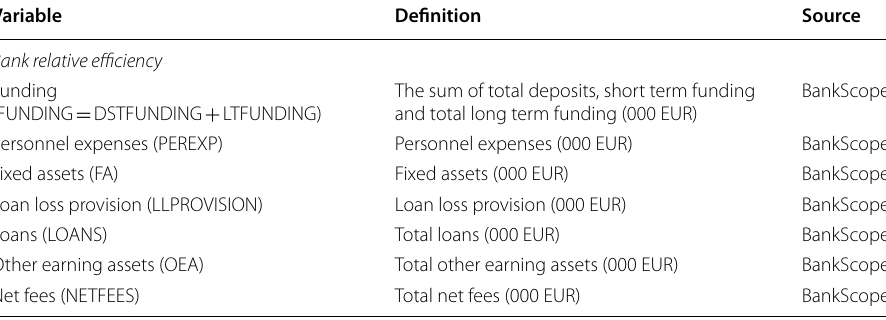
Table 3 List, definition, and source of variables used in the DEA